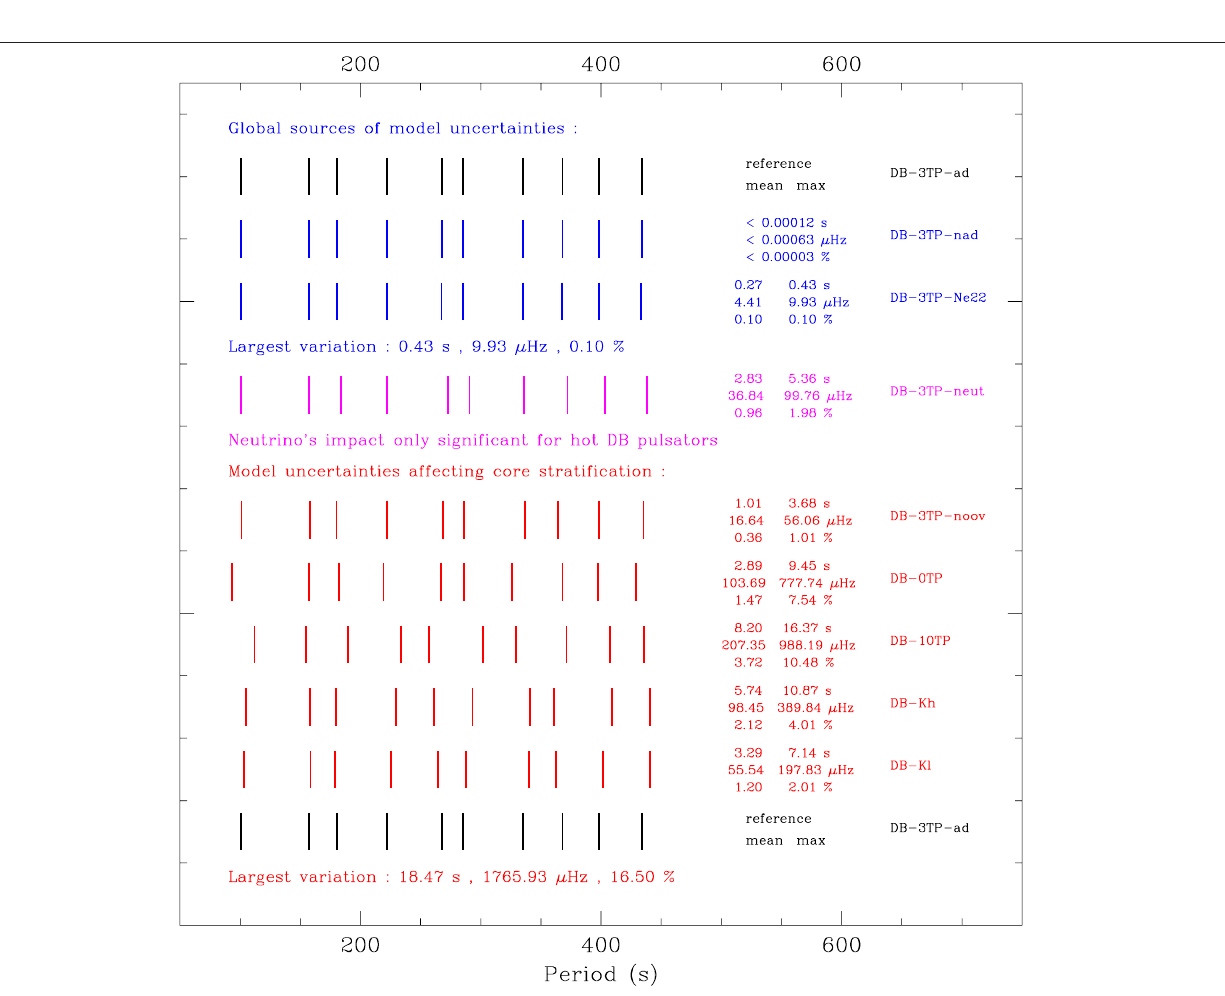
FIGURE9| Impactofvariousidenti fi edglobalandlocalizedsourcesofuncertaintiesonaselectionof10low-order( k =1 − 10),low-degree ( ℓ =1) g -modeperiods, representative of modes typical seen in the spectrum of a blue-edge pulsating DB white dwarf. The illustrated models are parametrized static structures in which everything is kept identical except the varied chemical pro fi les as reconstructed from Figure 2 models. The references for the chemical pro fi les with varying TPs (0: DB- 0TP, and 10:DB-10TP), with different 12 C ( α , γ ) 16 O reaction rates (DB-Kh,DB-Kl), and with extra-mixing (DB-3TP-noov) are from De Gerónimo et al. (2017). Global effects, including trace amount of 22 Ne (DB-3TP-Ne22), non-adiabatic effects (DB-3TP-nad), and the resolved neutrino cooling problem (DB-3TP-neut) are also calculated. Mean and maximum valueson the period and frequency differences relative to areference model (DB-3TP-ad) areshown on thebefore last column. Largest seen period variation is indicated at the